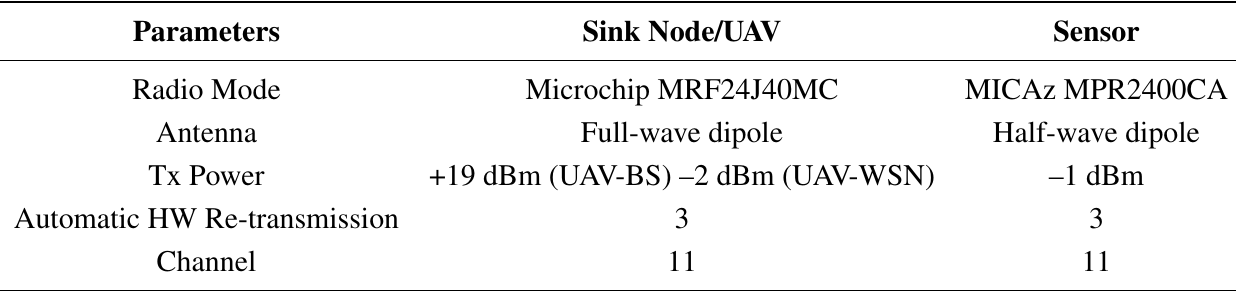
Table 1. Physical layer settings and other aspects of the